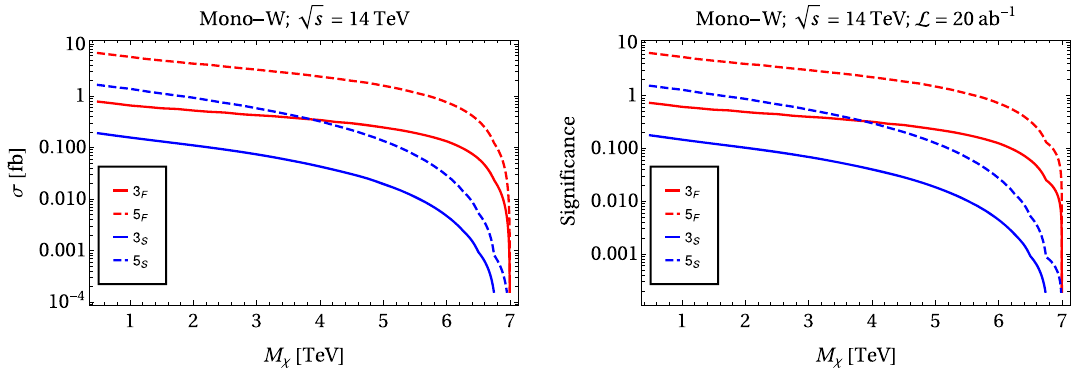
√ s = 14TeV. Right: significance of the mono- W search for